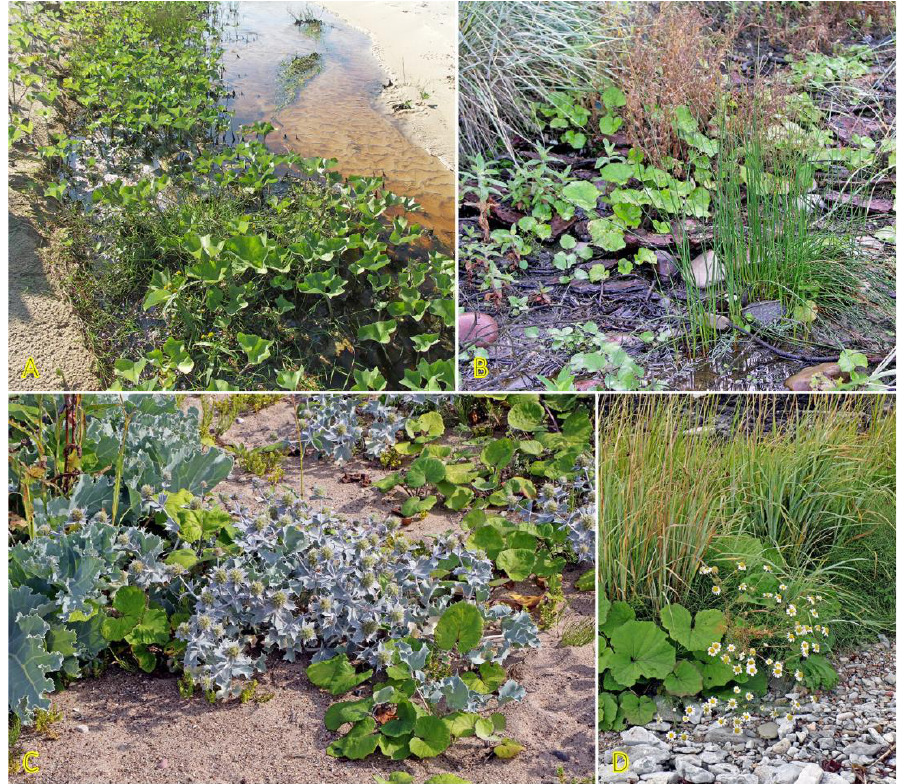
Figure 18. Tussilago farfara in the mouth of a stream on a sandy beach in Mazirbe, Latvia ( A ), on a spring-affected sandy beach together with Juncus balticus in Liepene, Latvia ( B ), on a sandy beach together with Eryngium maritimum and Crambe maritima on the island of Kihnu, Estonia ( C ), on a pebble beach with perennial vegetation together with Tripleurospermum maritimum on the island of Hiiumaa, Estonia ( D